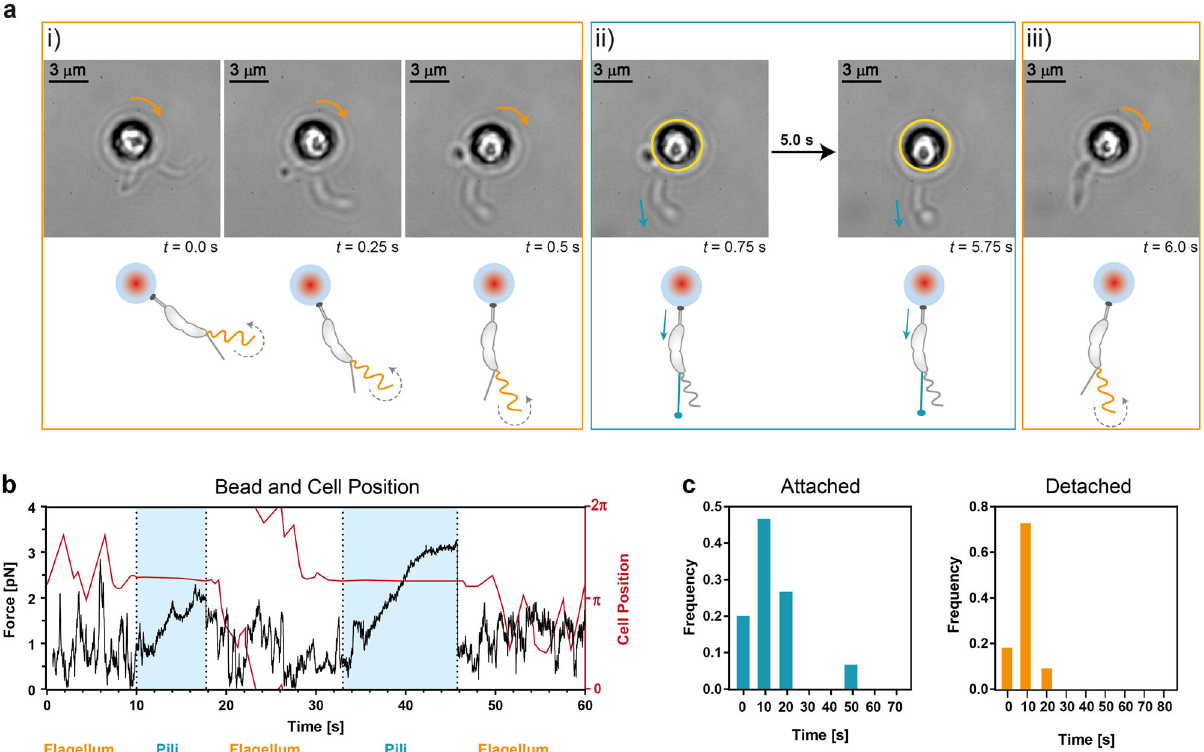
Fig. 4 Interplay of fl agellum and pili. a Competition between fl agellum and pili. (i) The active fl agellum causes a rotational movement of the bead in optical tweezers (indicated by an orange arrow). (ii) Upon attachment of a pilus, the rotational movement is interrupted (indicated by a turquoise arrow). (iii) When the pilus is released, gyration is resumed (indicated by an orange arrow). b Flagellum and pili domination alternates. Typical trajectory of a predivisional cell with fl agellum and pili attached on a colloidal bead in optical tweezers. When the fl agellum is rotating freely, the bead shows a gyrational movement (white area). When the pilus is attached to the surface, the bead is dragged out of the optical trap in one direction (blue area). The active pili stabilize the cell for the duration of the attachment, resulting in a straight horizontal line. At the bottom of the graph, the dominating cell appendage is indicated. c Duration of individual pilus attachment cycles and period in between individual pilus attachment cycles ( N = 4, 15 measurements for attachment cycles and 11 measurements for the period in between attachment